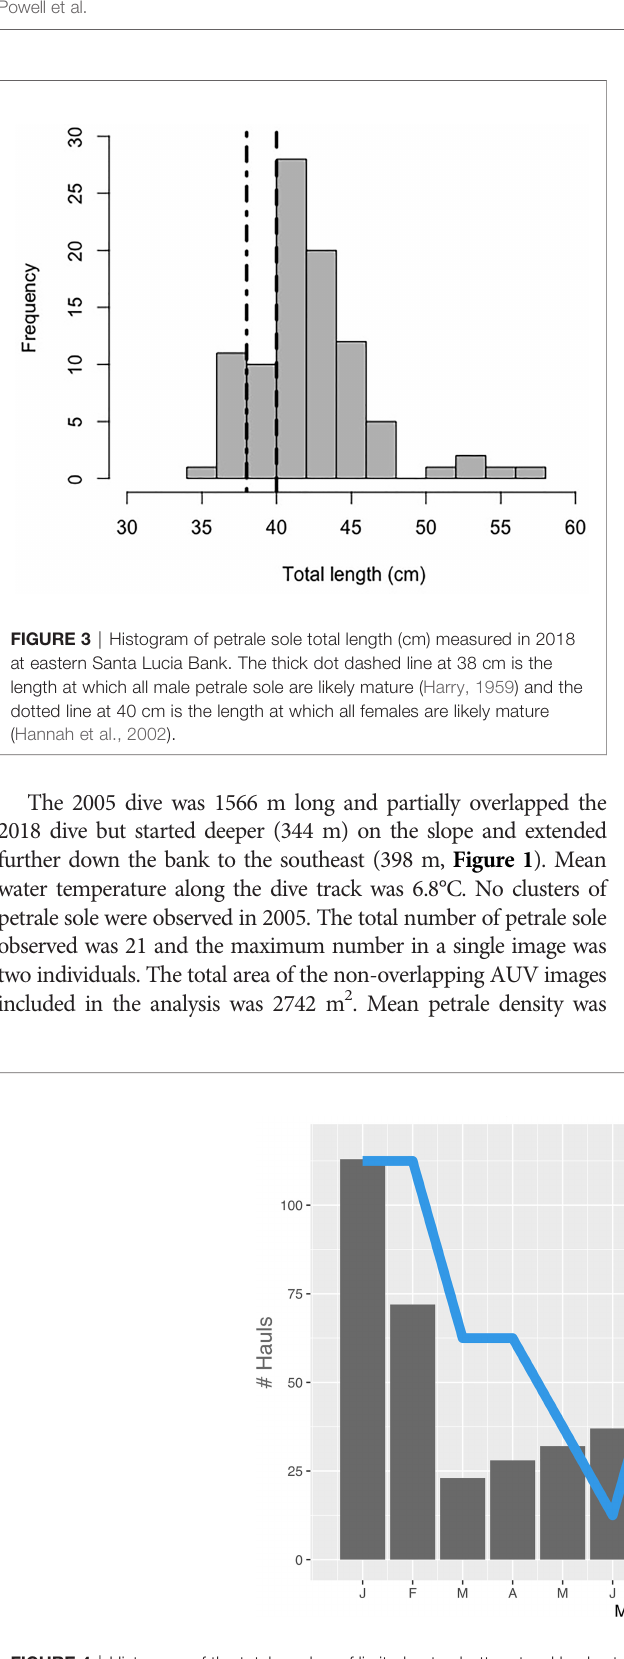
FIGURE 4 | Histogram of the total number of limited-entry, bottom trawl hauls at eastern Santa Lucia Bank from 2002 to 2019 broken down by month. The blue line represents the median rank of petrale sole by weight in hauls for each month.